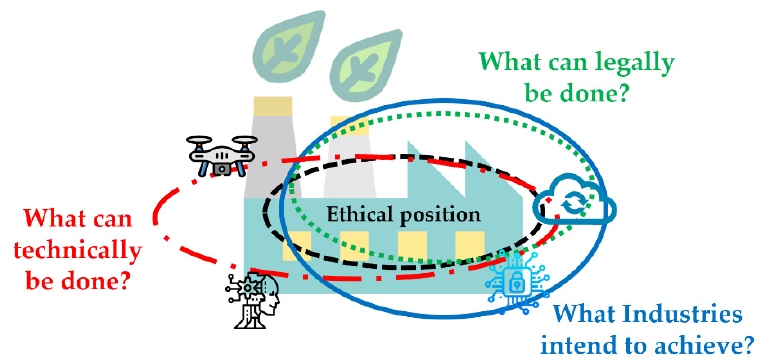
Figure 1. Ethical dilemmas in enabling technologies used in Industrial IoT (diagram adapted from IBM model for ethical analysis [12] and redesigned in context of this